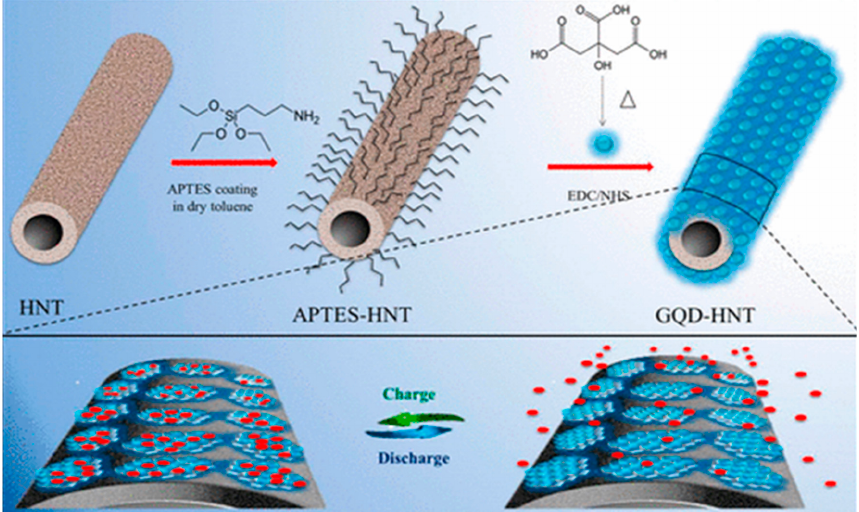
Figure 20. Synthesis of GQD-HNT composite electrode material for supercapacitor applications. Reprinted with permission from Ref. [162].